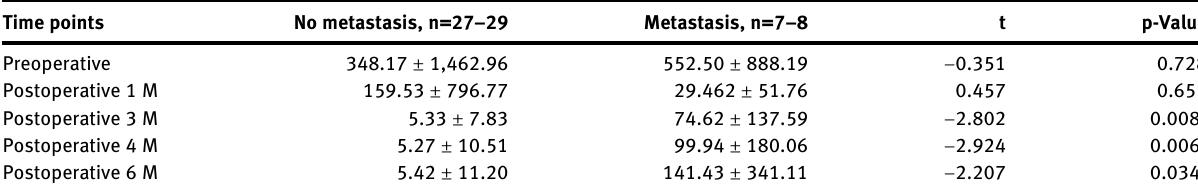
Table  : Association between AFP levels (ng/mL) and postoperative metastasis.